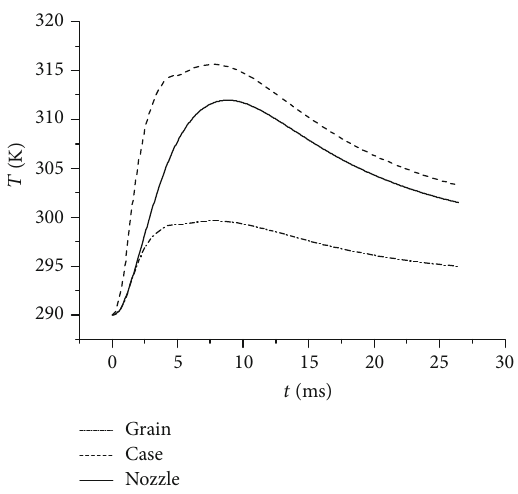
Figure 10: Interface temperature